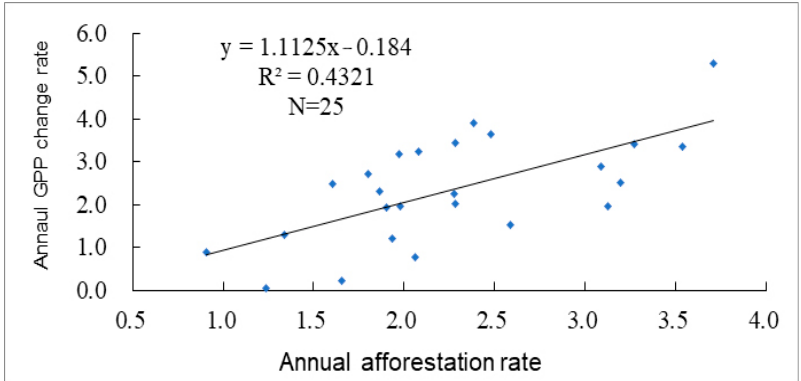
Figure 6. Relationship between annual change rates (%) in GPP and forestland (afforestation) rate (%).